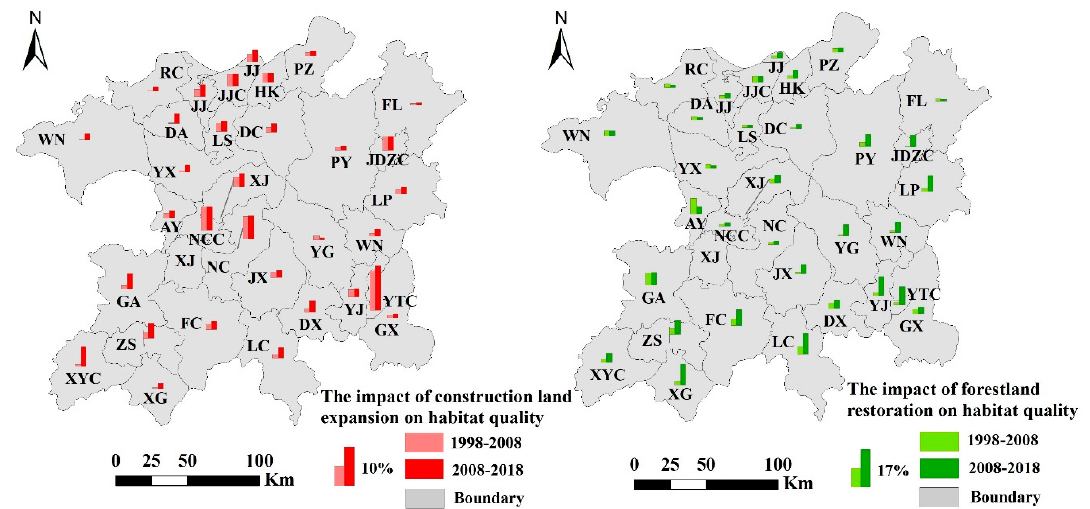
Figure 11. The impact of construction land expansion and forestland restoration on habitat quality. Note: please refer to Figure 10.